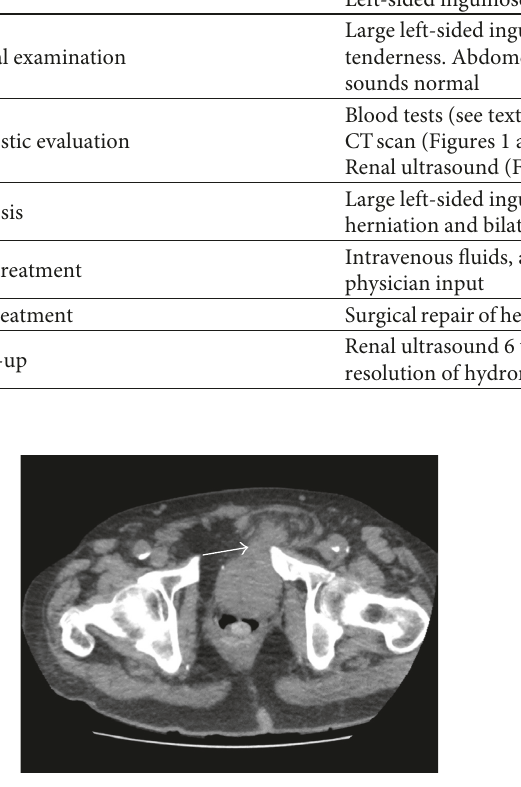
Figure 1: Axial CTscan section showing herniation of the bladder into the left inguinal region.